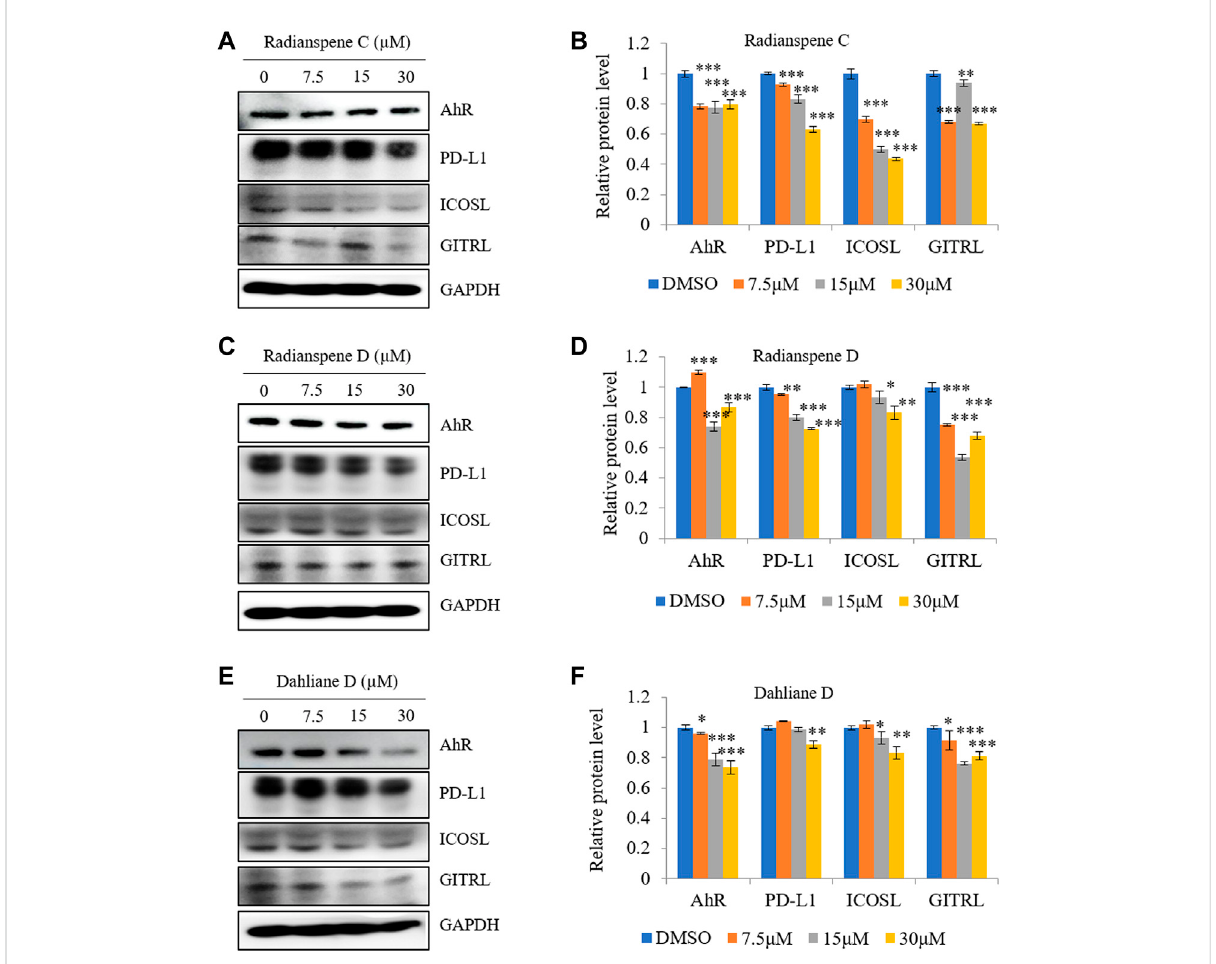
FIGURE 5 Effect of radianspenes C and D, and dahliane D, on expression of AhR, PD-L1, ICOSL, and GITRL. The level of AhR, PD-L1, ICOSL and GITRL proteinbyradianspenesC (A,B) andD (C,D) ,anddahlianeD (E,F) treatmentwereshown. Dataarepresentedasthemean±SD, n =3.* p < 0.05;** p < 0.01; *** p < 0.001 compared with the DMSO-treated